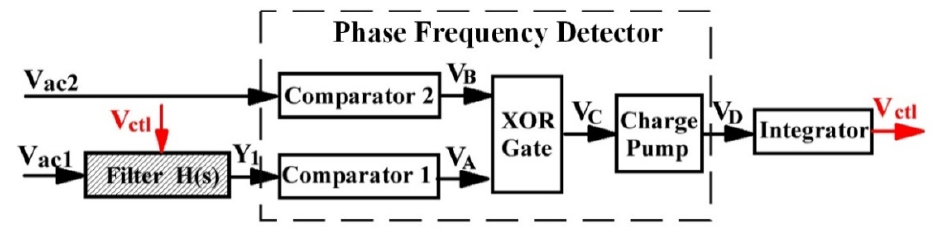
Figure 6. Schematic of the signal observation.